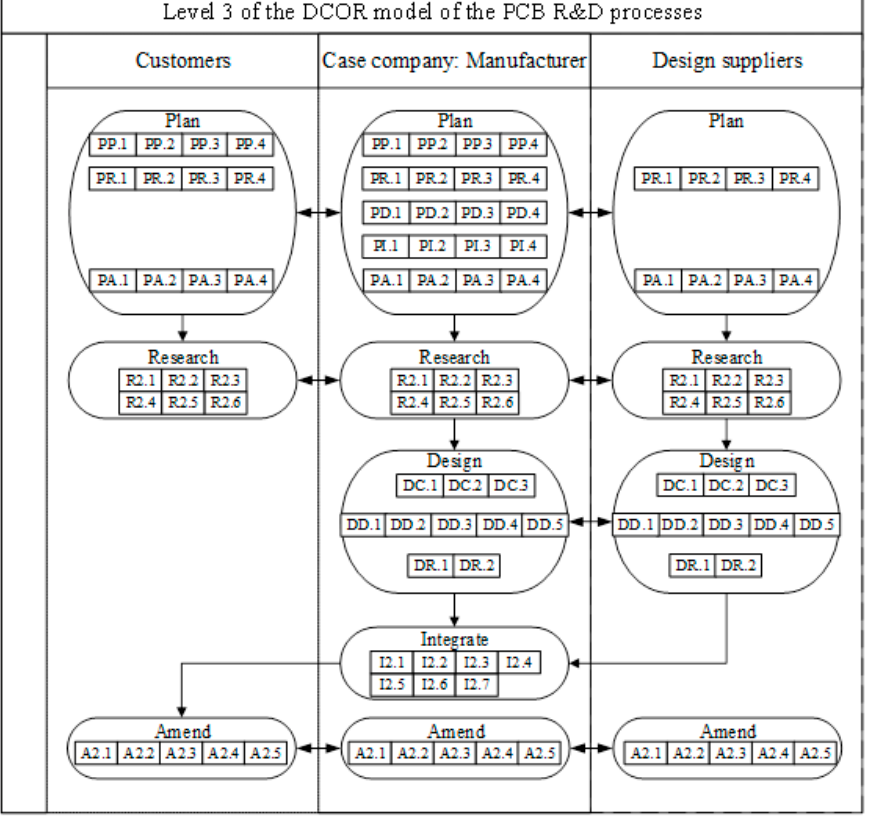
Figure 6. Level 3 of the DCOR model of the PCB R&D processes.